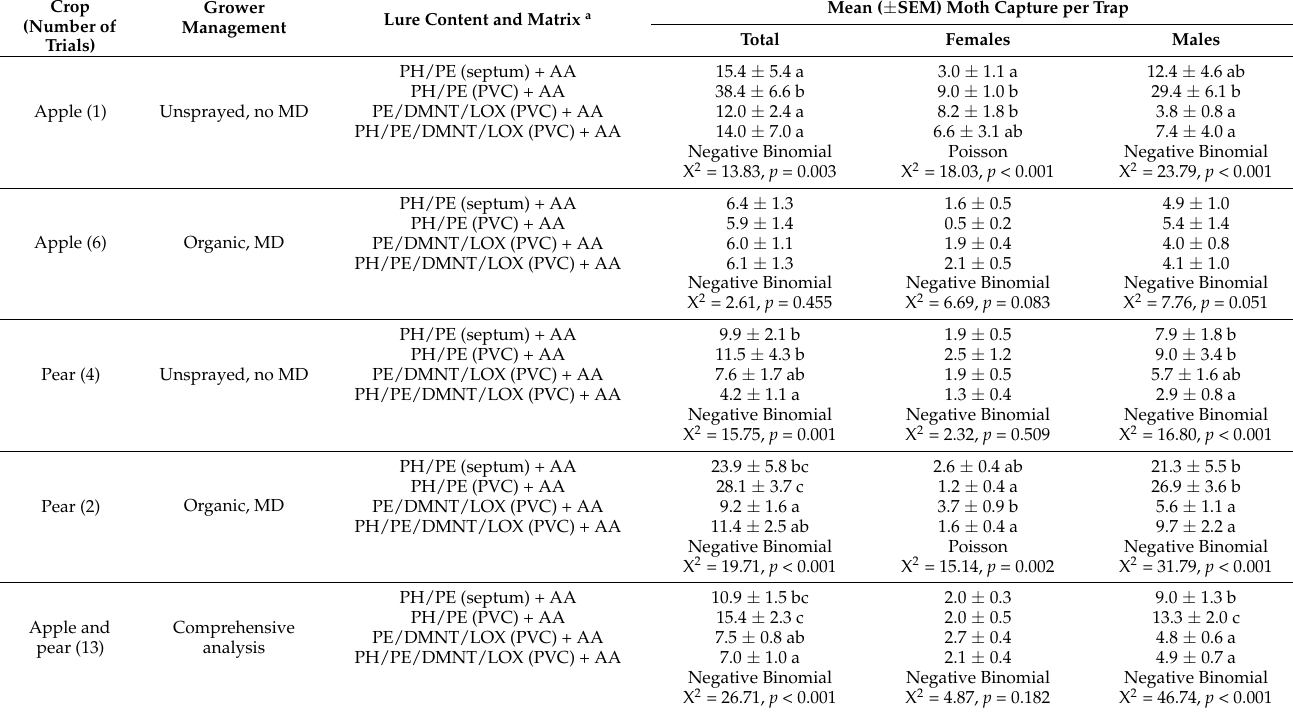
Column means within each crop-management category followed by different letters are significantly different, p < 0.05 (Tukey’s test). X 2 = chi-square value for the factor lure, p = probability p (X 2 ) for differences among lures. a The acetic acid loaded in a membrane